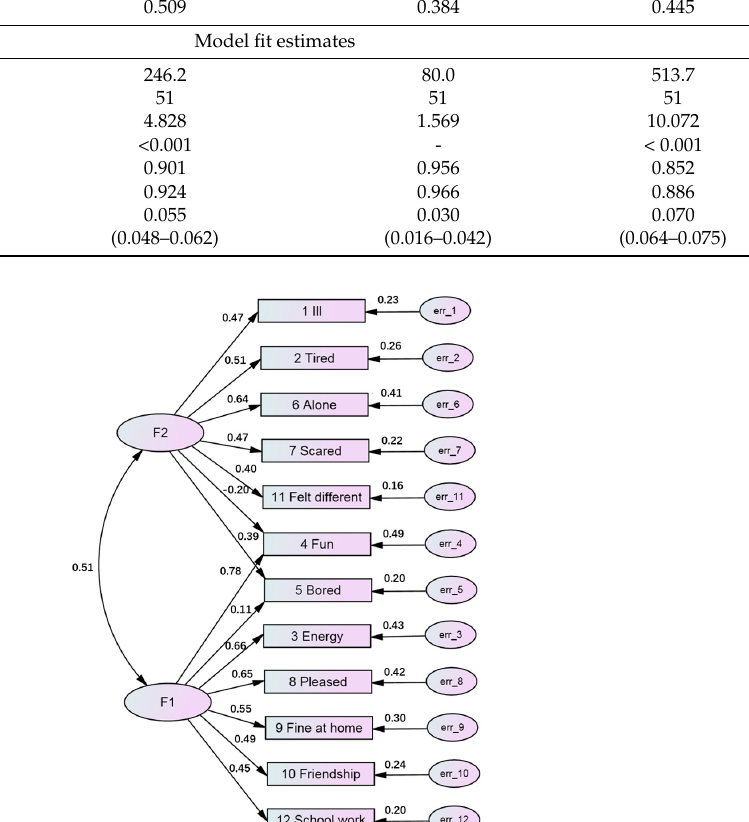
Table 7. Estimates of two-factor model of the HRQoL scale obtained from the confirmatory factor analysis of randomly selected sub-group 2 of the entire sample and sub-samples of participants who reported headache or no headache in the last year. Estimates Headache in the Last No Headache in the Randomly Selected Sub-group Last Year Year of the Entire Sample (N = 1858) (N = 1252) (N = 647) Standardized regression weights (factor loadings) and direction of associations: